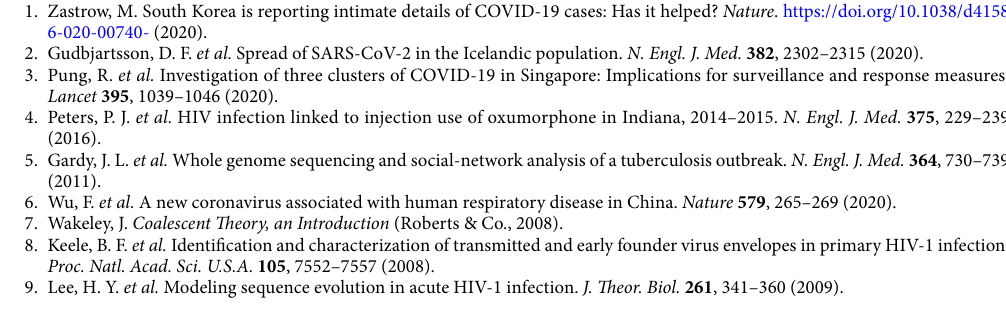
Figure 4. Maximum likelihood tree of all 66 cases. ( a ) Maximum likelihood tree of all 66 South Korean cases that were sequenced. The church cluster (cluster 6) is marked by blue brackets, and the hospital cluster (cluster 7) is marked by light blue. The branch support values of the tree using the SH-like likelihood ratio test were estimated as around 1. The most recent common ancestor sequence of clusters 6 and 7 is presented by blue circle and the strain that shared two common mutation markers with this ancestor is presented by red circle. ( b ) Star-like phylogeny of the 37 church cluster cases (cluster 6, dark blue in ( a )) ( c ) Star-like phylogeny of the 11 hospital cluster cases (cluster 7, light blue in ( a